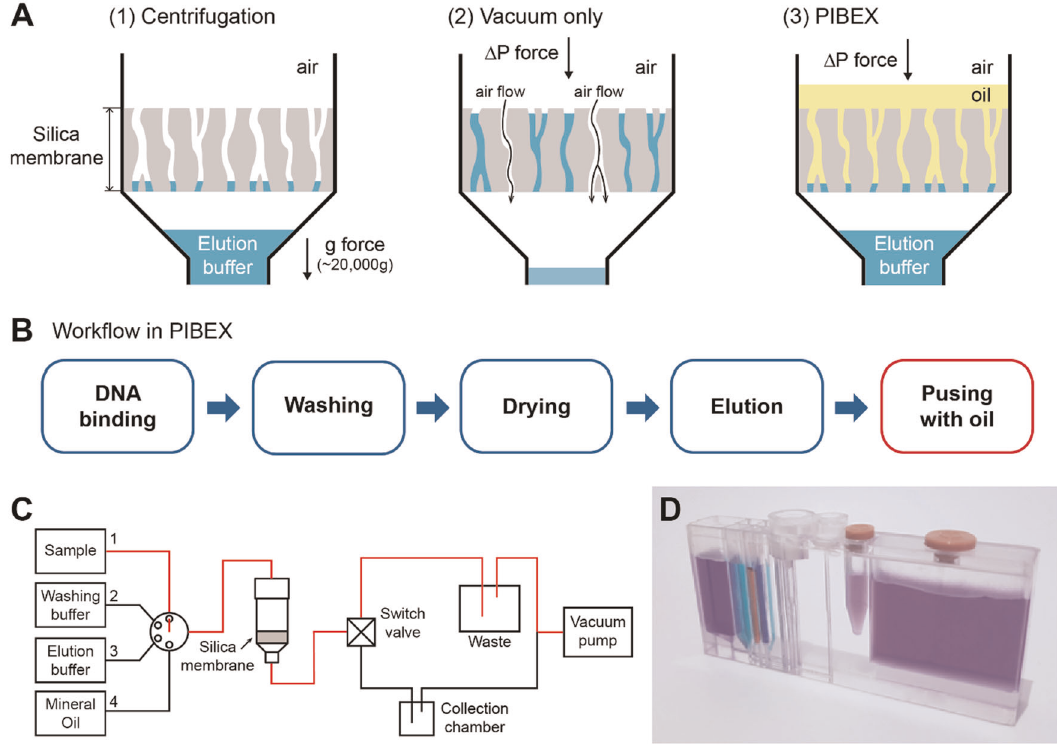
Fig. 1 Integrated Micro fl uidics (PIBEX) for cfDNA extraction. a Comparison of cfDNA extraction methods. The schematic illustrates mechanisms of extracting residual eluents in silica membrane using centrifugation, vacuum, and immiscible fl uid and vacuum (PIBEX), respectively. This work is reproduced under CC BY 4.0/partial use and word modi fi cations from the original. 36 b Work fl ow of the proposed micro fl uidic process of cfDNA extraction. The micro fl uidic PIBEX method is identical to the conventional spin column method, except for the last additional phase of “ pushing with oil, ” which collects eluents that have remained inside the silica membrane using an immiscible solvent. c Schematic of the fl ow channel at the DNA binding step. The fl ow pathway is selectively connected from sample chamber to collection chamber, as depicted by a red line. d Photograph of an integrated micro fl uidics for cfDNA extraction into PIBEX